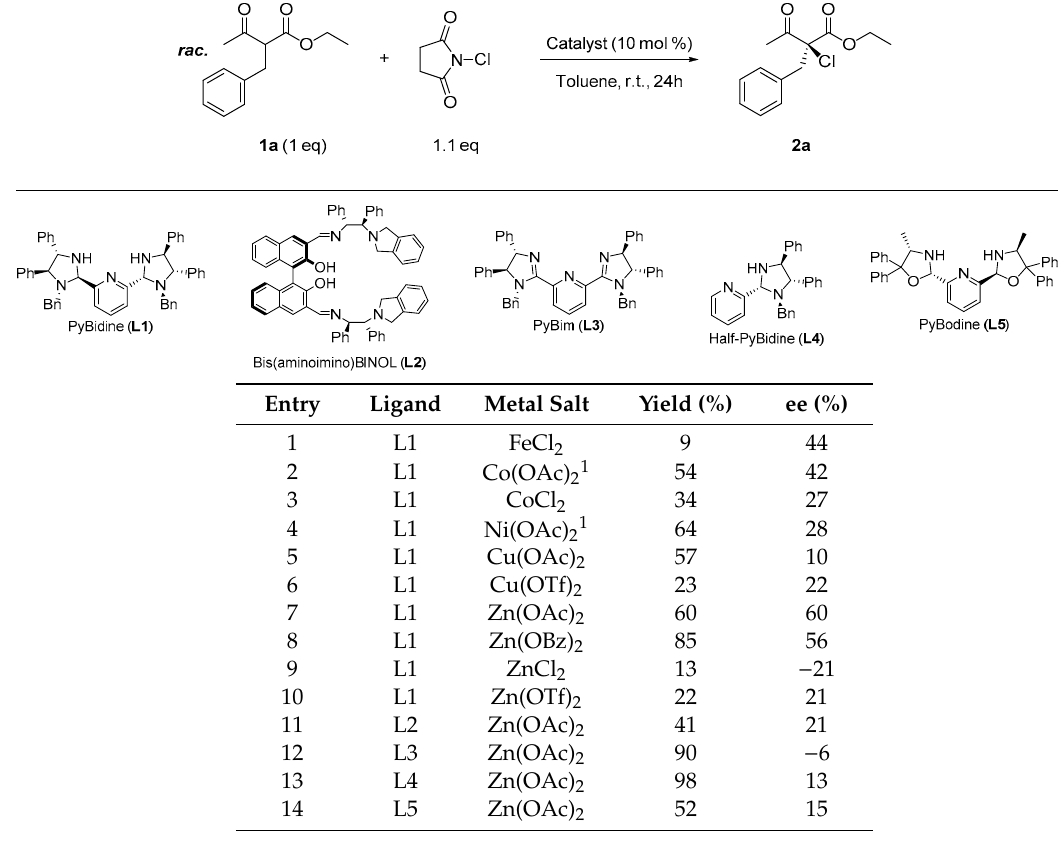
Table 1. First screening of metal catalysts for asymmetric chlorination of β -ketoester.